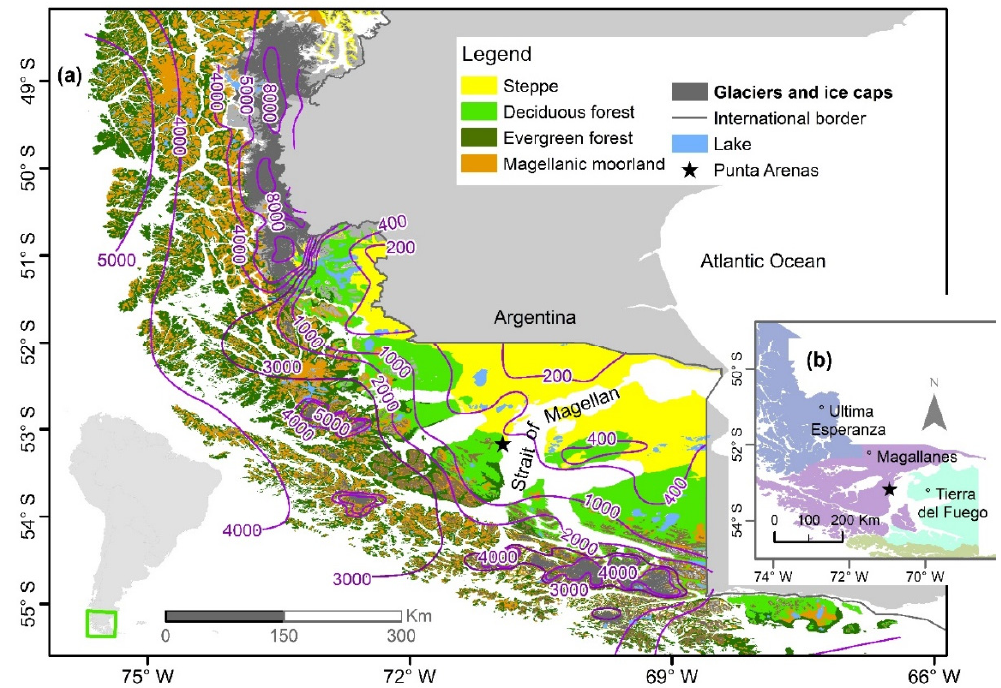
Figure 1. ( a ) Map of the study area including main vegetation types, isolines of precipitation, glacier extents, and lakes. Inlay: ( b ) names of Chilean provinces covered in this study. Vegetation distribution [4,30], while the information of isohyets, glaciers, lakes and political limits are from Infraestructura de Datos Geoespaciales de Chile [31].